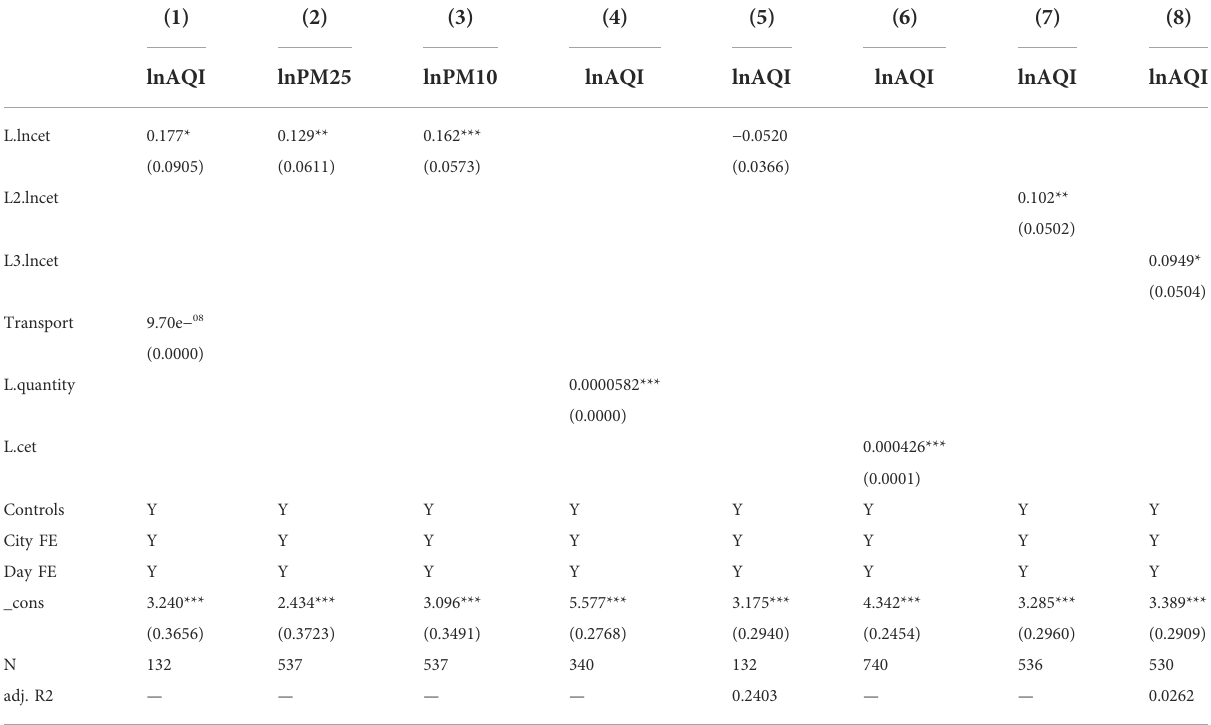
TABLE 8 Robustness